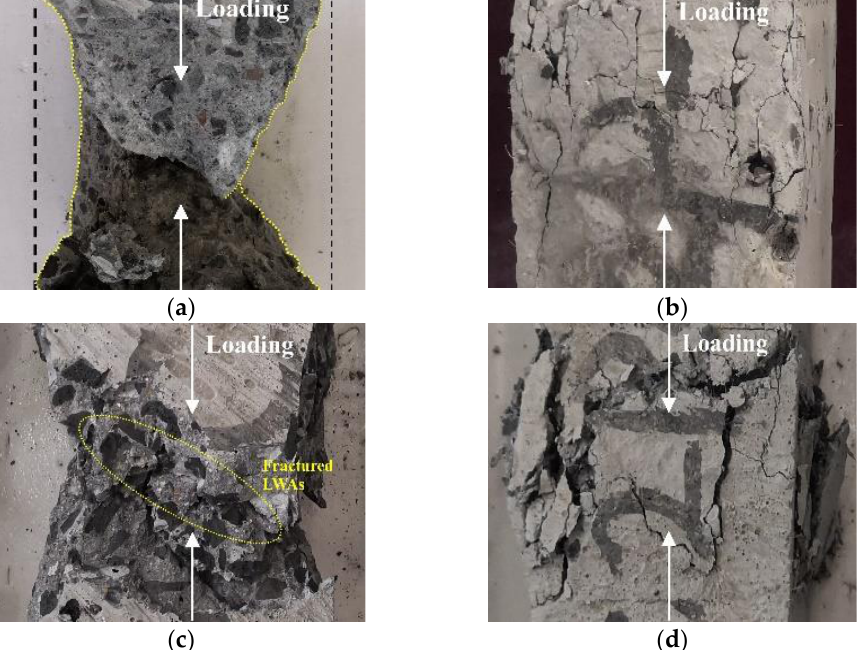
Figure 2. Failure modes of specimens under axial compression (W/B = 0.3): ( a ) Plain LWAC; ( b ) PFLWAC; ( c ) CFLWAC; ( d ) HFLWAC.